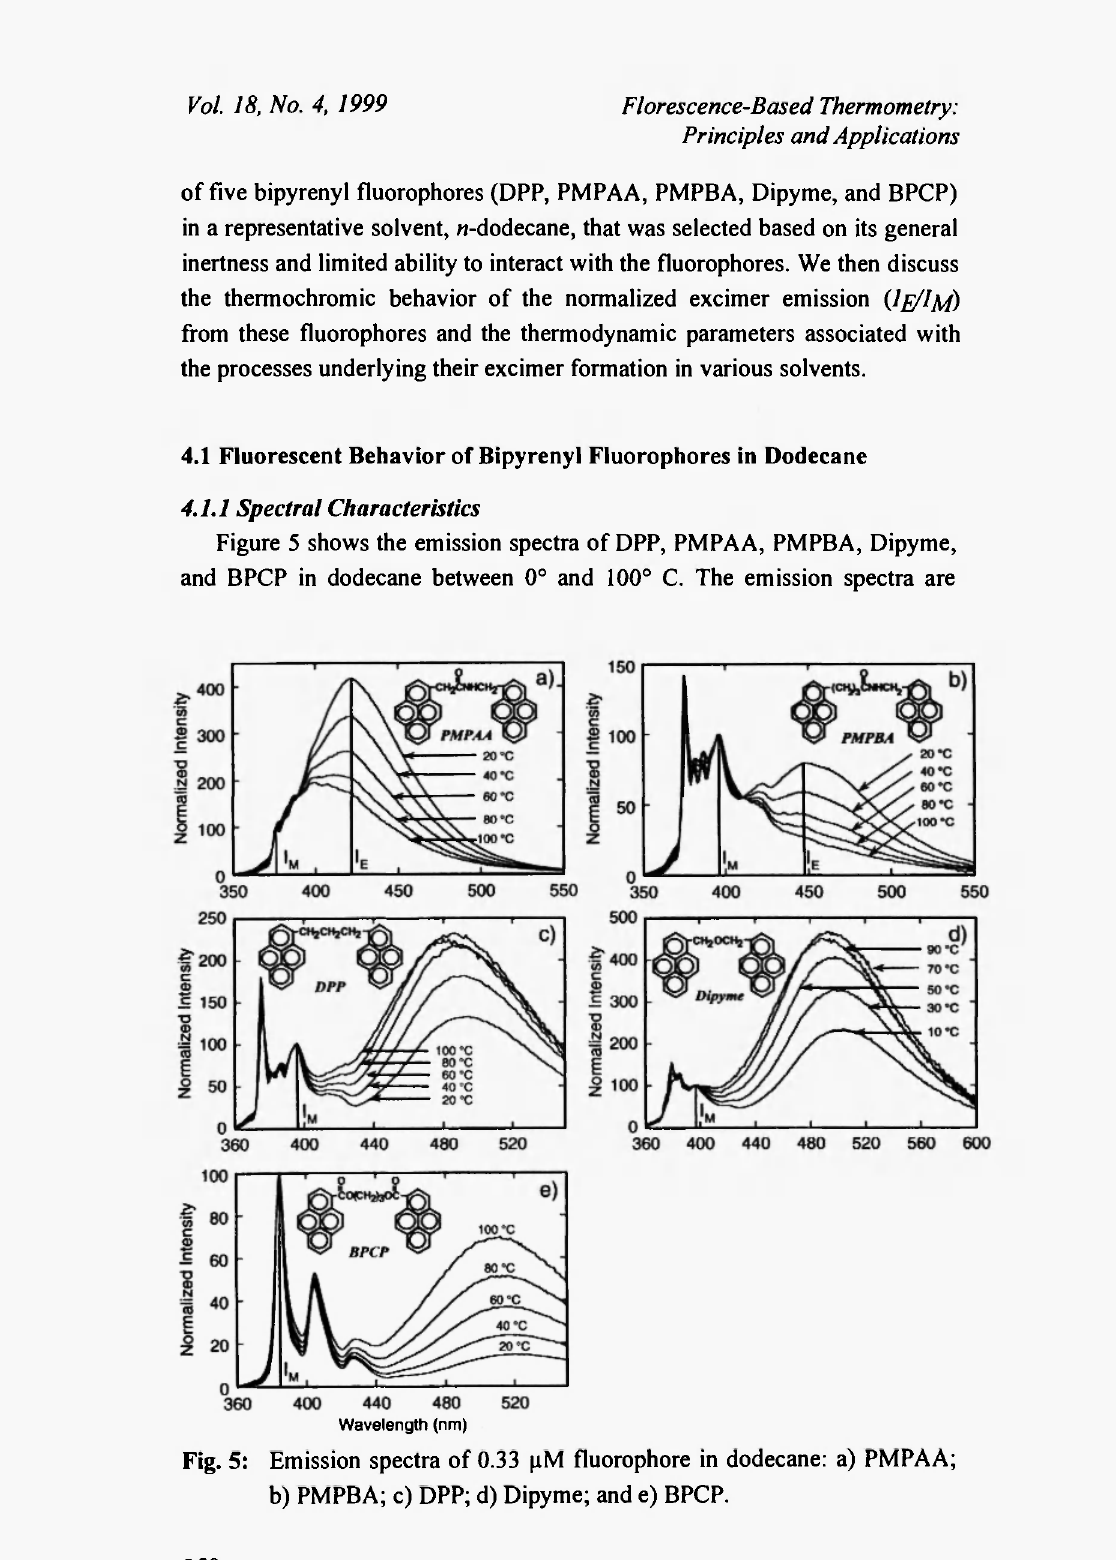
Fig. 5: Emission spectra of 0.33 μΜ fluorophore in dodecane: a) PMPAA; b) PMPBA; c) DPP; d) Dipyme; and e)